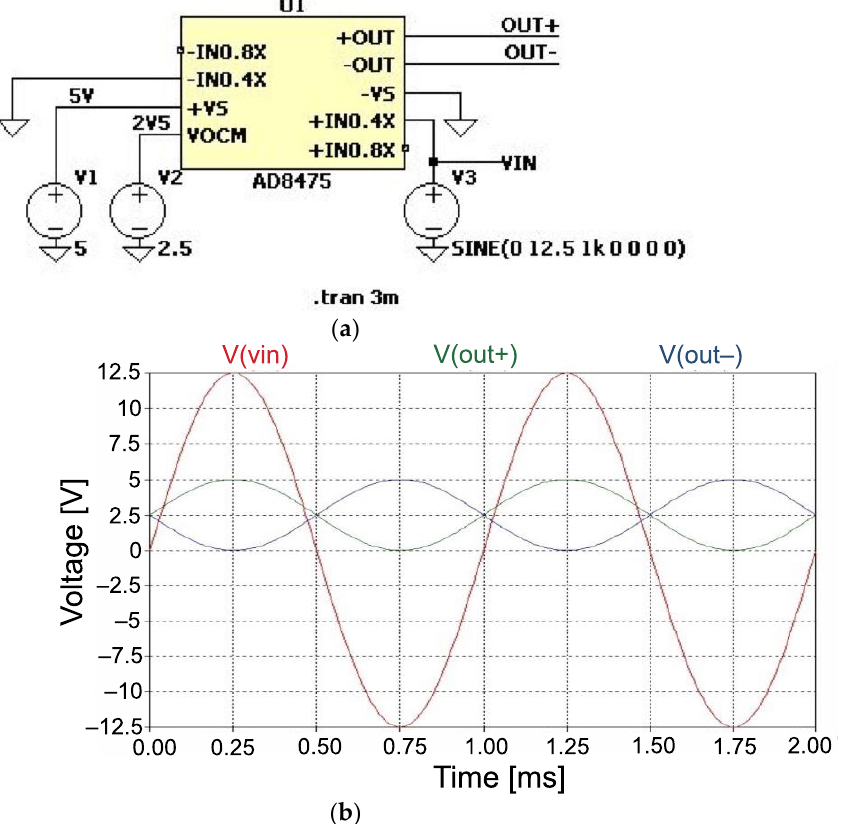
Figure 4. Scaling test diagram in LTSpice ( a ). Scaling simulation results using AD8475 in LTSpice ( b ).